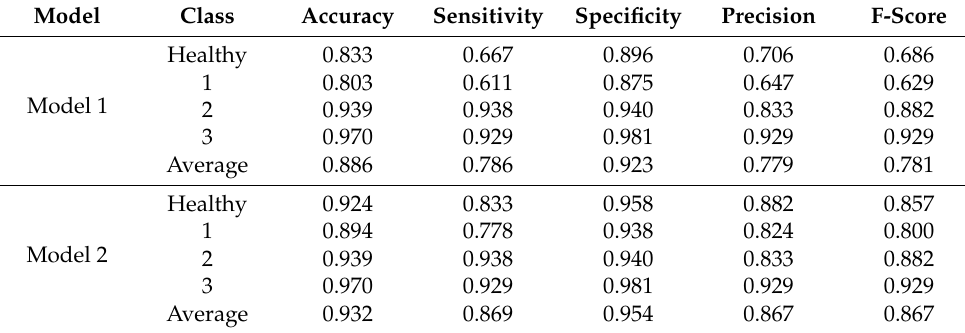
Table 6. Comparison between Model 1 and Model